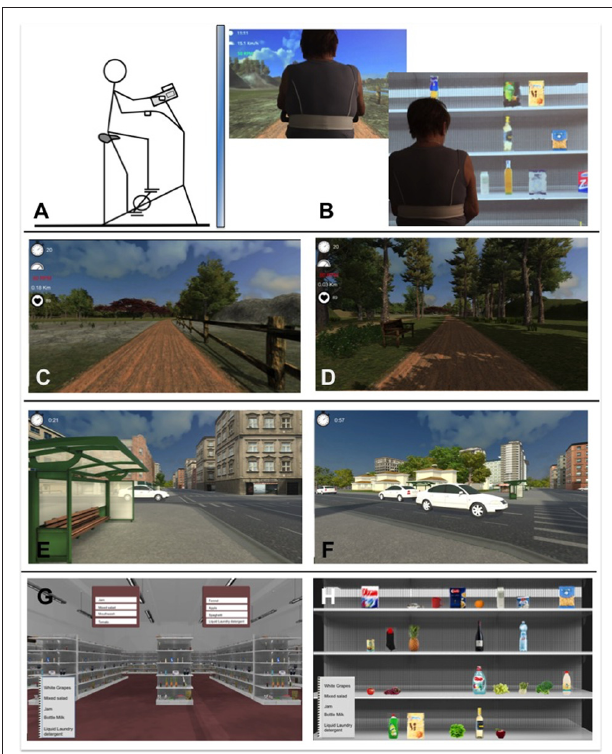
FIGURE 2 | Sketch of the Physical and Cognitive Training protocol. (A) The cycle-ergometer. (B) The back view of the subject while conducting the test in virtual environments (VEs, 1,3). (C,D) VEs (1): “riding a bike in a park”. (E,F) VEs (2): “crossing roads—avoiding cars”. (G,H) VEs (3): “making the grocery shopping in a